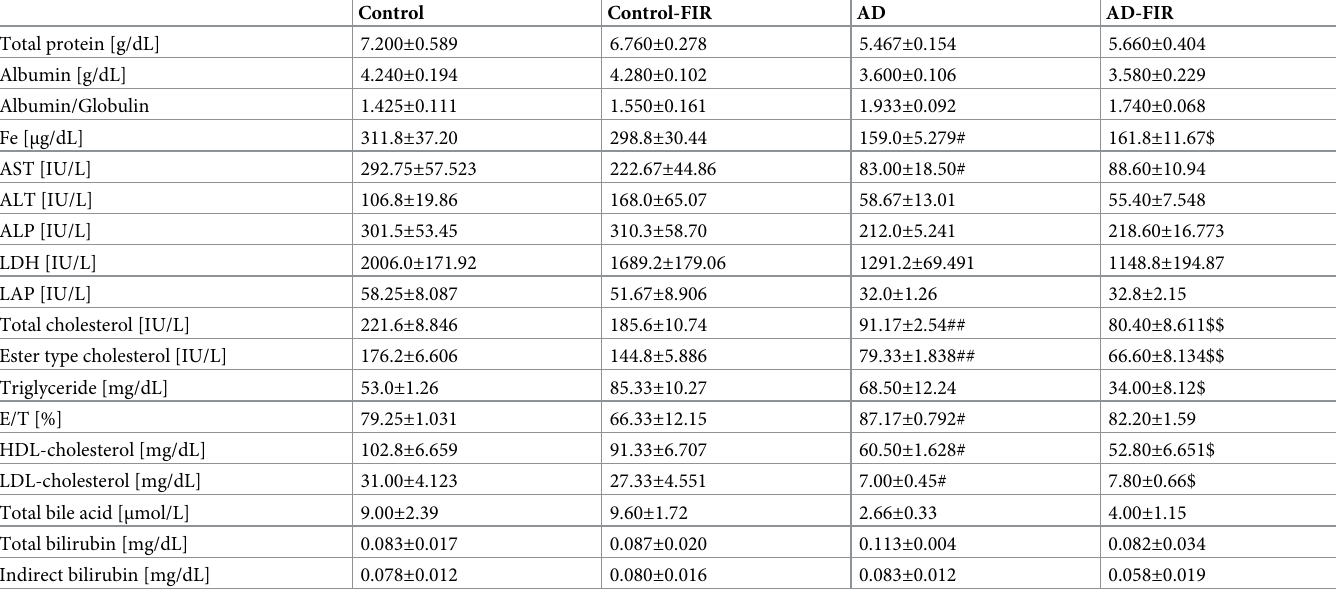
Table 1. Changes in serum parameters for control and AD mice maintained in the presence or absence of FIR light.